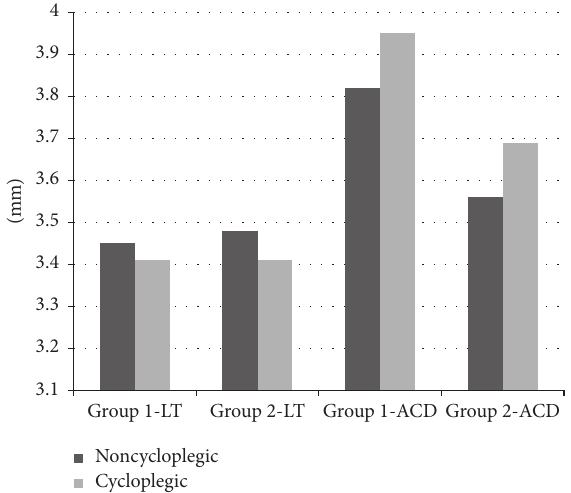
Figure 3: RLP changes with cycloplegia. RLP: relative lens